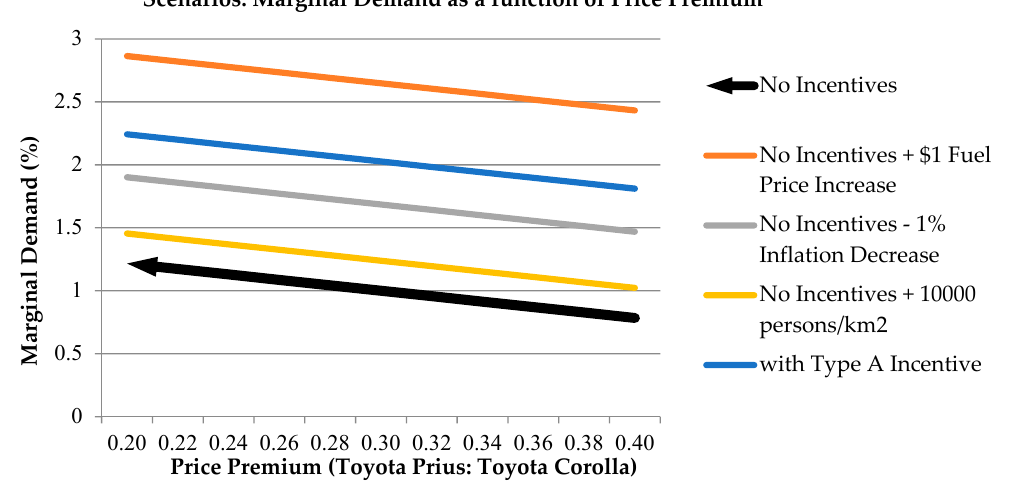
Figure 4. Marginal Demand as a function of Price Premium for various scenarios .